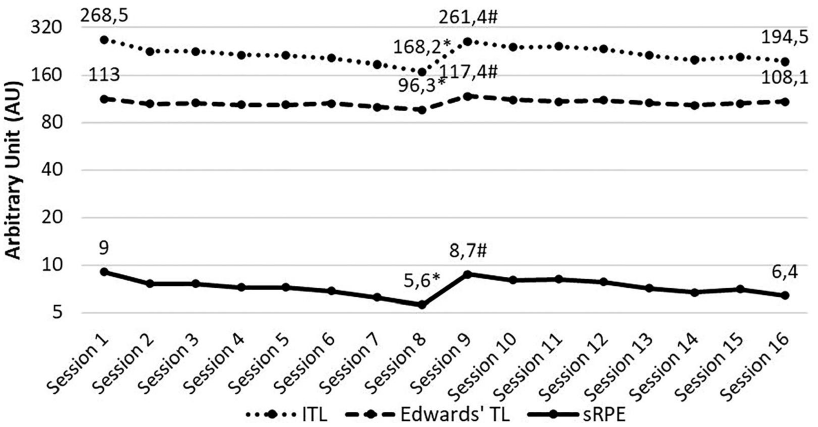
Figure 4 - Mean values of ITL, TRIMP and sRPE verified in FT PROGRAM sessions. ITL (F = 8.906), TRIMP (F = 12.08) and sRPE (F = 8.874) FT PROGRAM sessions. ∗ p < 0.05 session 1. #p < 0.05